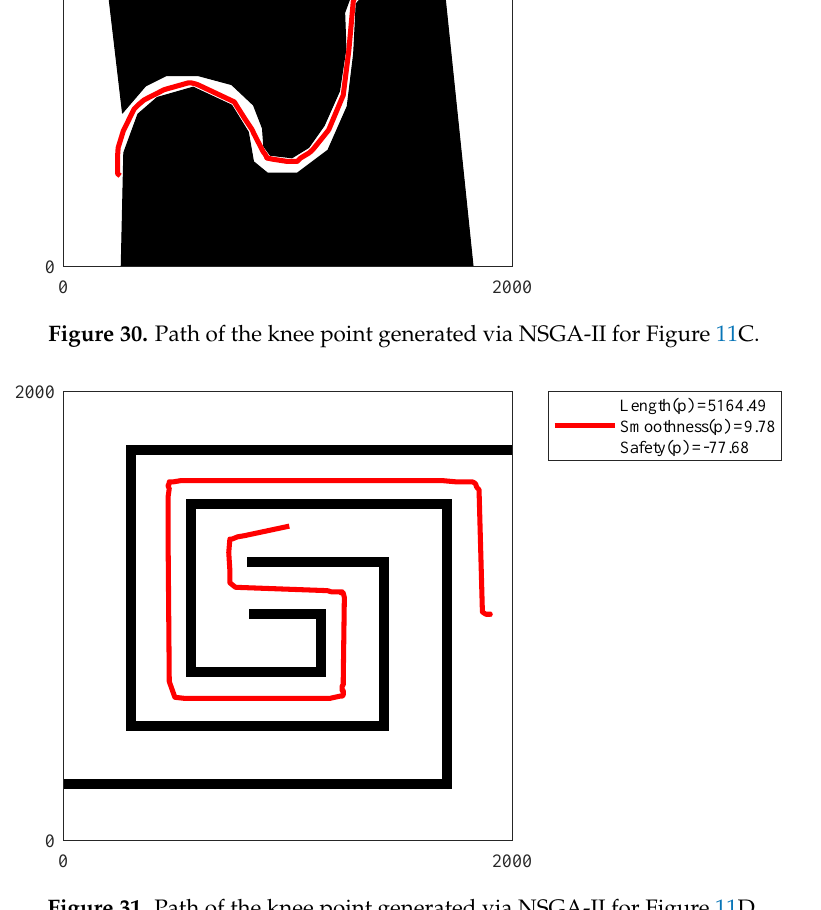
Figure 31. Path of the knee point generated via NSGA-II for Figure